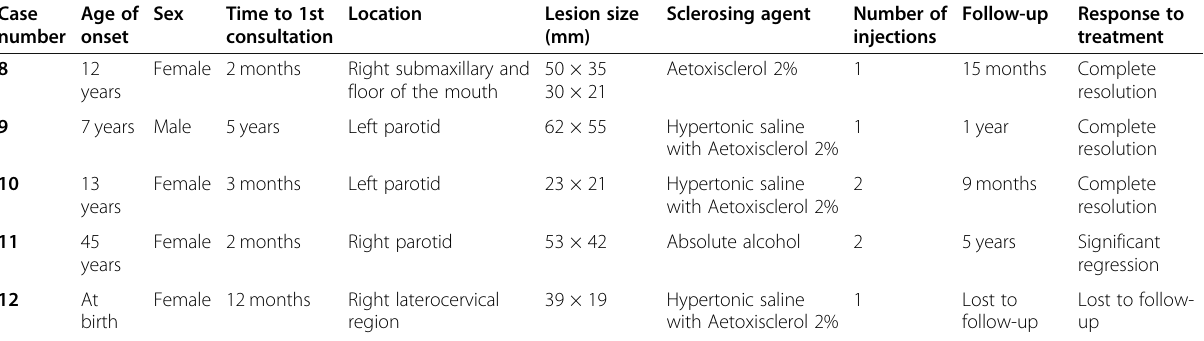
Table 4 Clinical profiles and response to treatment in our patients treated with sclerotherapy Case Age of Sex number onset